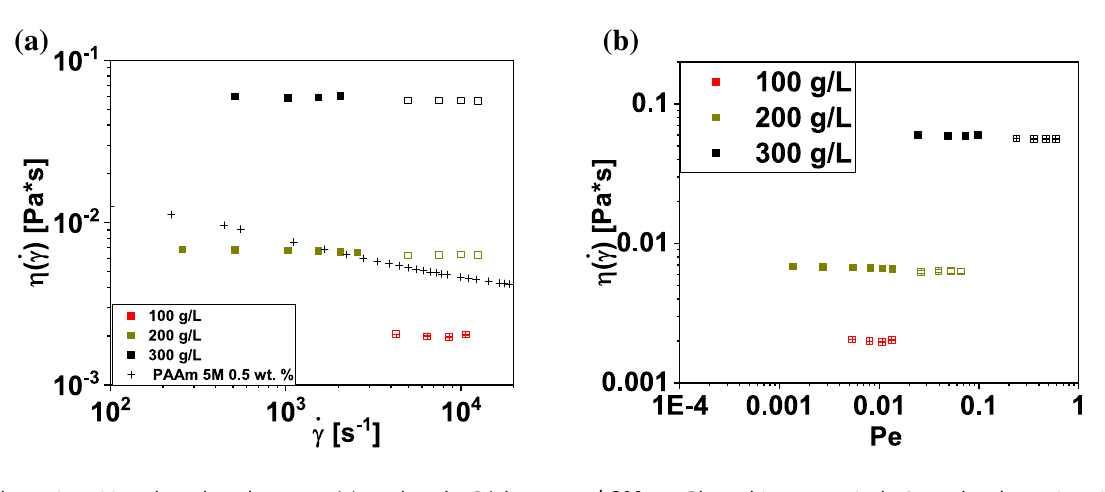
Fig. 4 Shear viscosities plotted vs shear rate ( a ) and vs the Péclet number ( b ) for the 100, 200 and 300 g/L BSA solutions. Filled and empty symbols indicate measurements taken with the 800